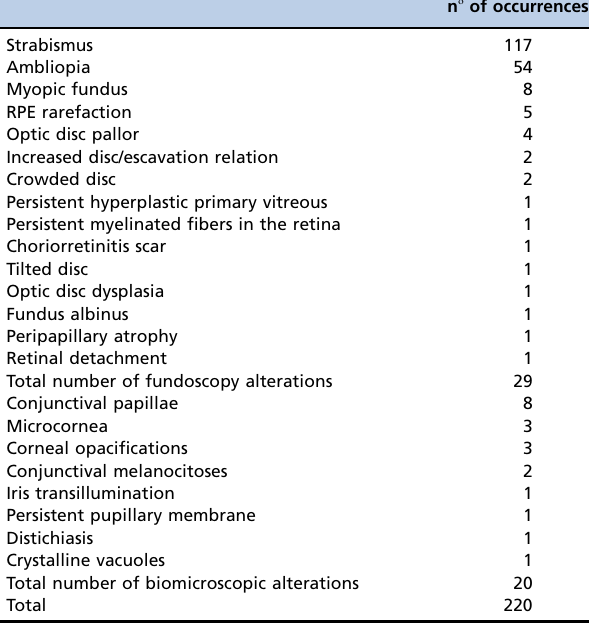
Table 3 - Diagnoses and Alterations